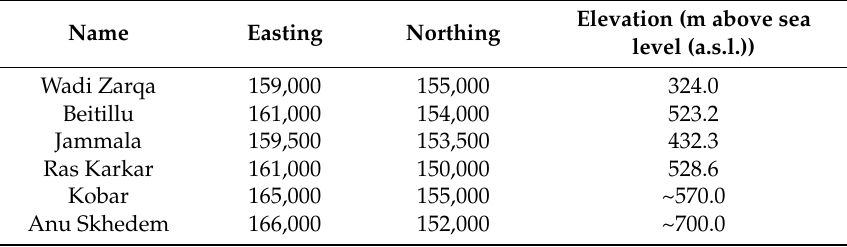
Table 4. Main spring groups in the Wadi